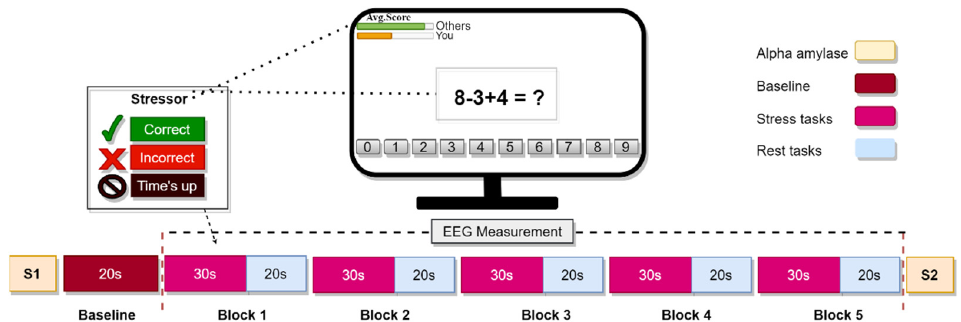
Figure 1. Experiment block design. A total of five blocks for the stress and rest tasks. In each block, arithmetic tasks were generated for 30 s followed by 20 s of rest. Alpha-amylase samples (S1–S2) were taken five minutes before the experiment began as a baseline and five minutes after the experiment ended.